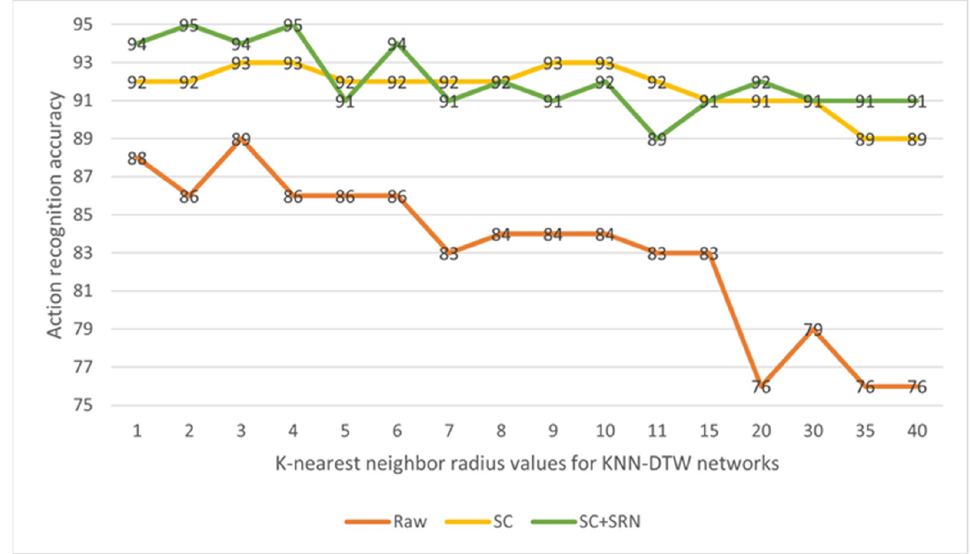
Figure 6. Classification results for KTH-4 with different radius k parameters using the KNN-DTW network (the results are retained as integers).